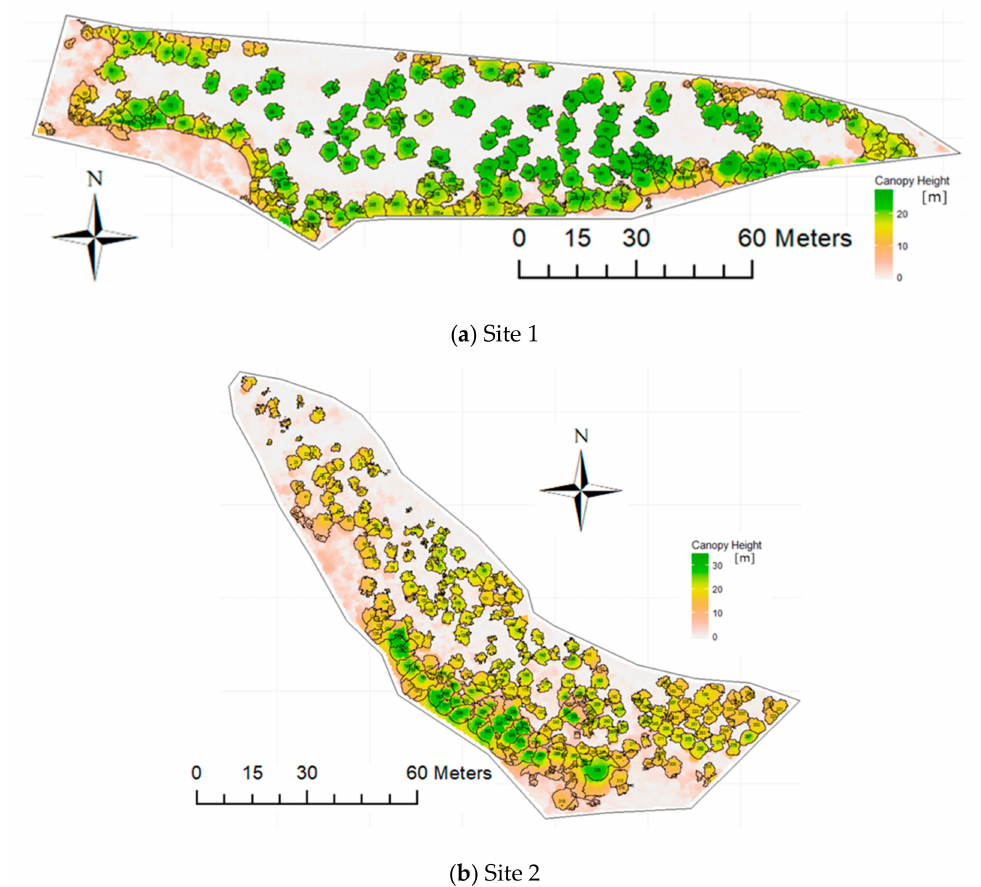
Figure 9. Detected individual tree crowns. Each segmented shape by black line represents individual tree crown. A black point and number in each tree crown are detected tree top and tree ID, respectively. Color from red to green shows canopy height. The threshold for the lowest tree height was set to 8.0 m so reddish areas are ignored canopy